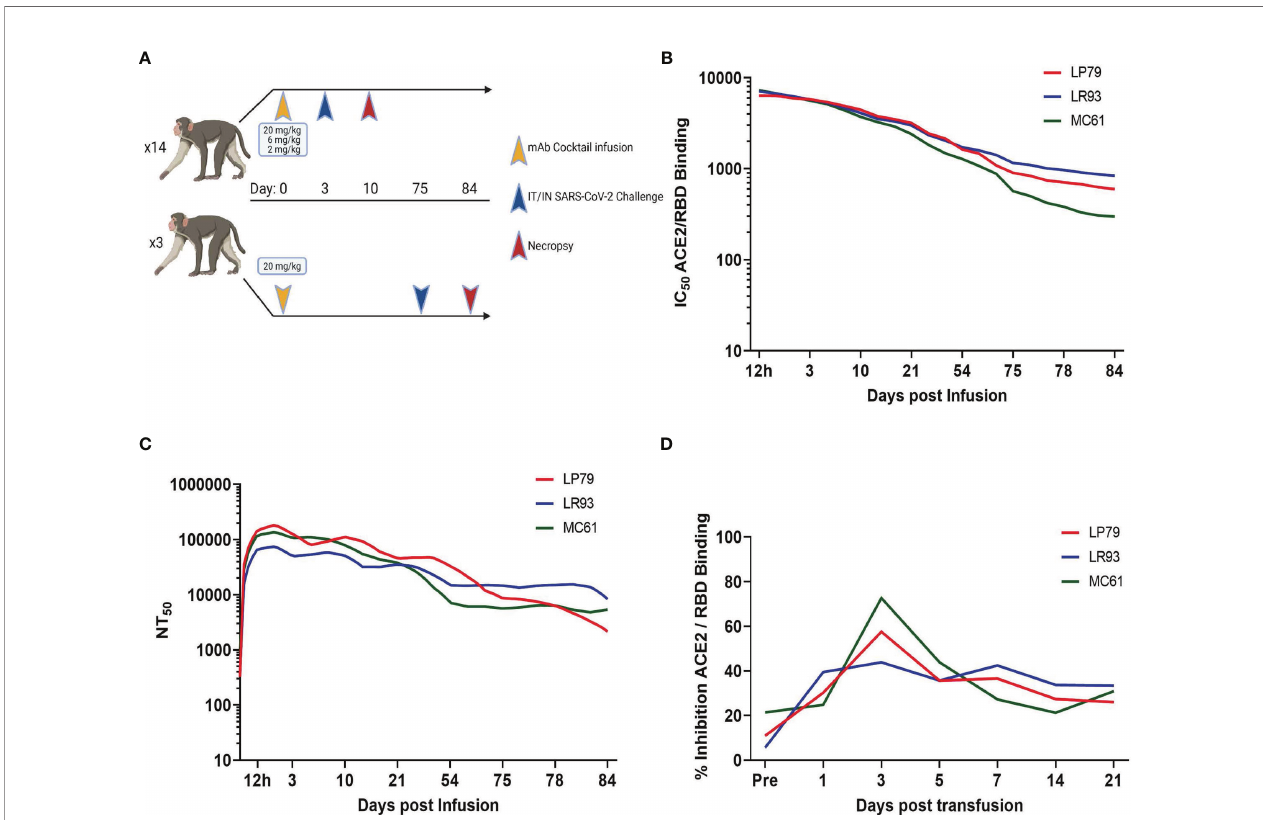
FIGURE 1 | Study Design and Antibody Kinetics. (A) Three different dosages (20, 6 and 2 mg/kg) of mAb cocktail consisting of equal amounts of C-135 and C-144 were administered three days before challenge. Separately, animals administered 20 mg/kg of mAb cocktail were challenged 75 days post administration. Antibody kinetics in serum were followed by both surrogate ELISA (B) and pseudovirus neutralization assay (C) , and BAL supernatant antibody kinetics followed by surrogate ELISA (D) for these animals (ID numbers LP79, LR93 and